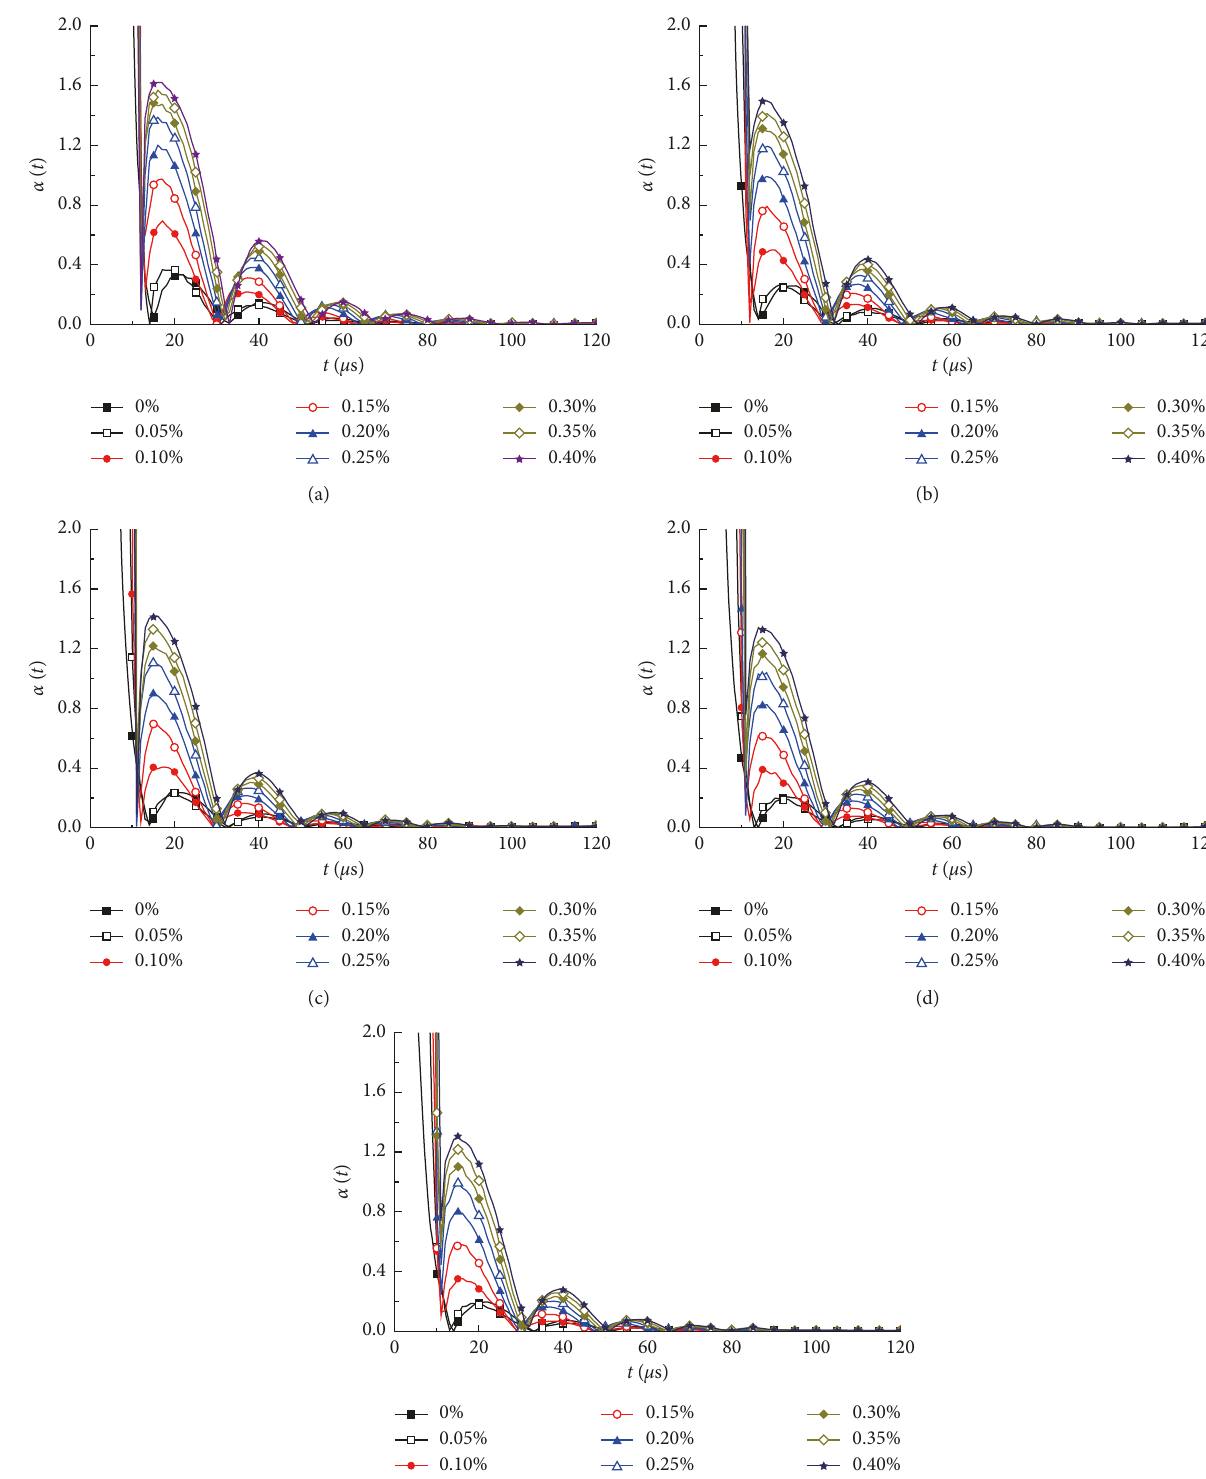
Figure 9: Stress nonuniformity coefficient α (c) E 28GPa, (d) E (cid:30)